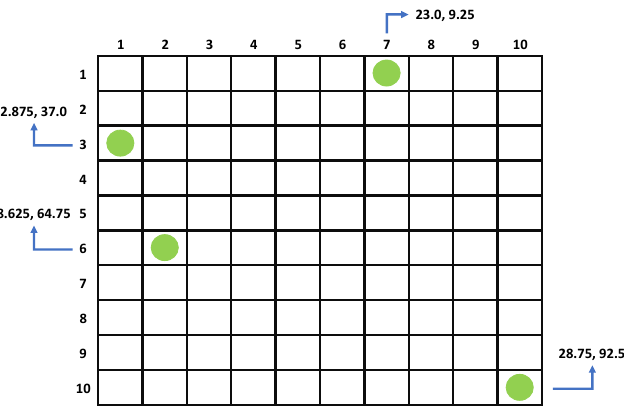
Figure 2. Example of space normalization.